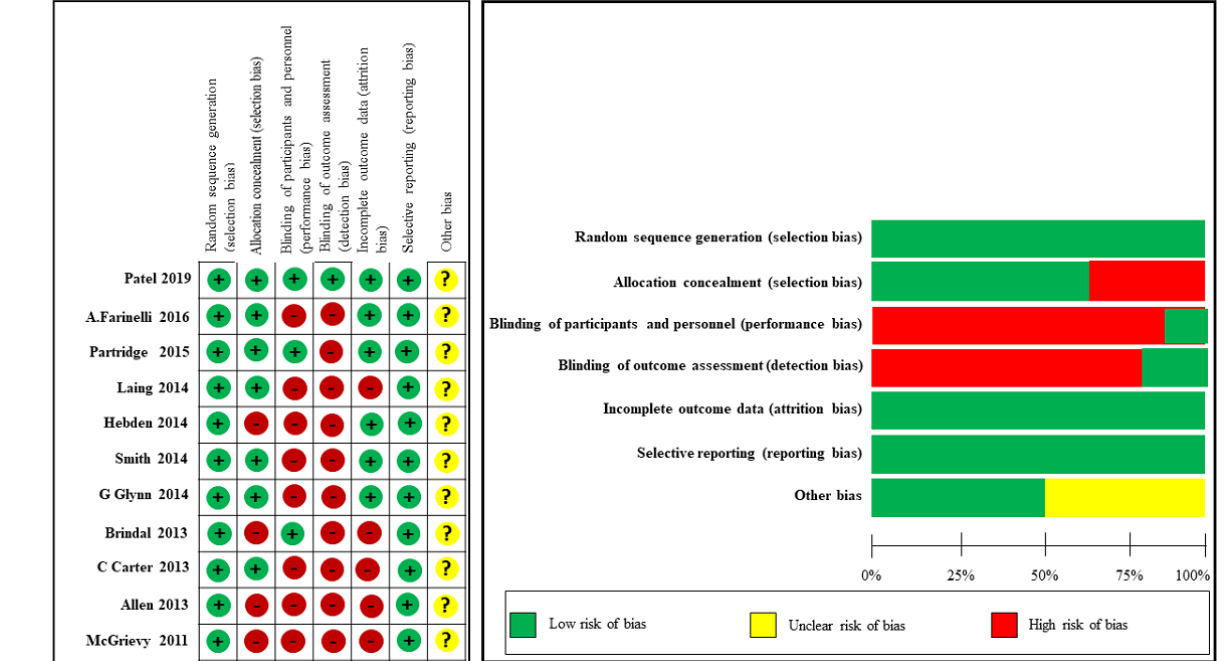
Figure 2. Risk bias assessment of the included